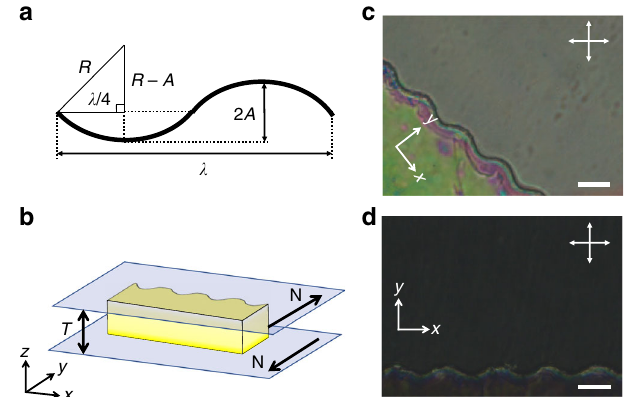
Fig. 1 Schematic of experiment. a Schematic of the wall shape with relevant parameters: radius of curvature R , amplitude A , and wavelength λ . b Schematic of the experimental setup ( N denotes rubbing direction, T denotes thickness of the cell). c , d Cross polarized images of liquid crystal near the wavy wall with the long axis either ( c ) at a 45° angle to the polarizer or ( d ) perpendicular to the polarizer. The scale bars are 20 μ